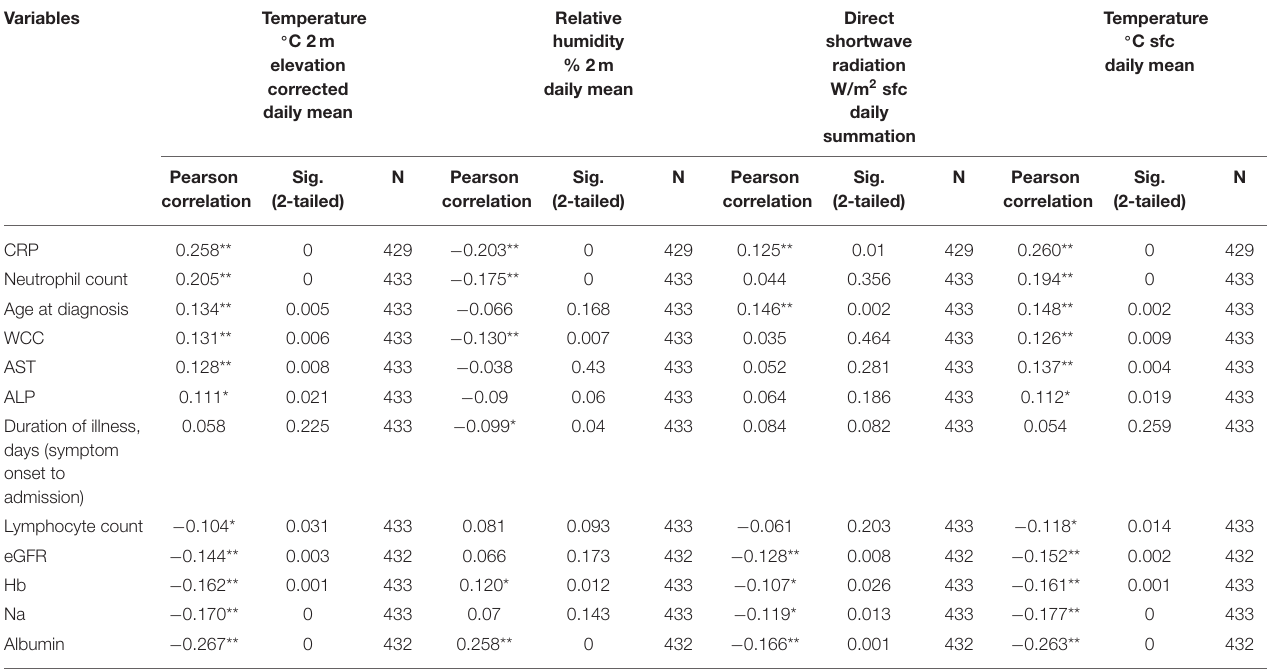
TABLE 4 | Correlation between the significant weather variables (temperature, humidity, and radiation) on the day of admission with patients’ clinical and laboratory parameters. Variables